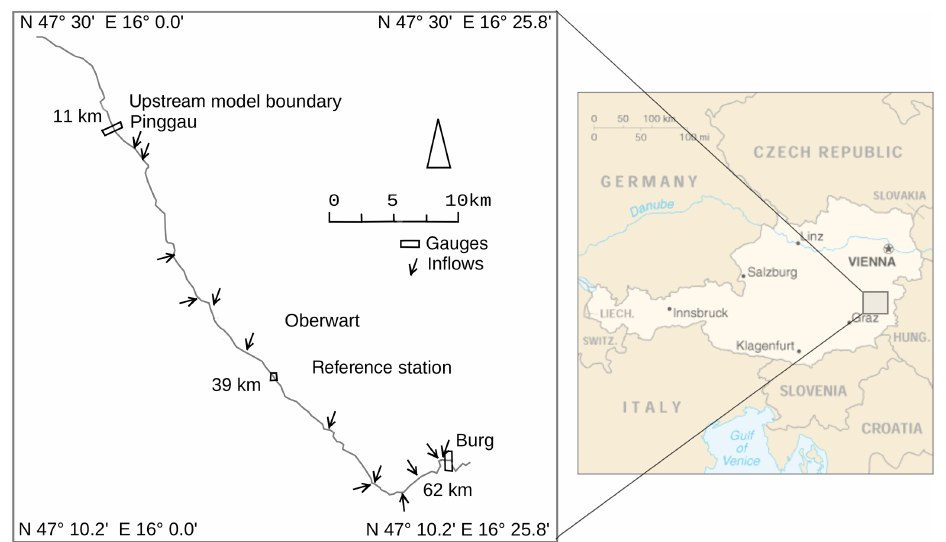
Figure 1. The study region in the Pinka showing gauges, tributaries and the reference station (kilometre markers shown as distance from